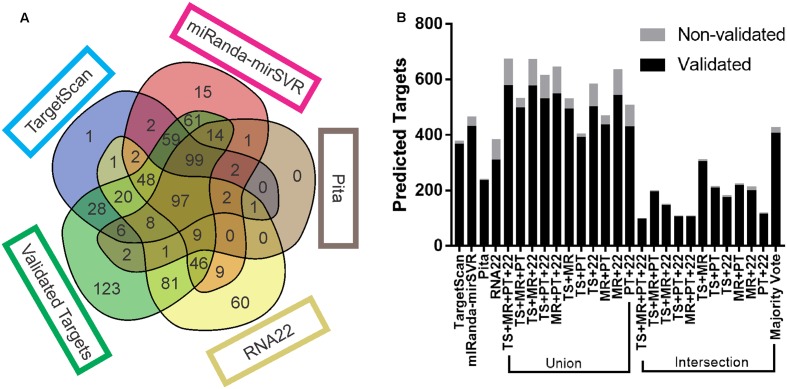
Target prediction output comparison.
(A) Venn diagram of the number of validated and non-validated targets predicted by each tool, as well as the number targets that were not predicted. (B) Total number of validated and non-validated targets predicted by each tool and combinatorial approach. Venn diagrams from all replicates are available at Supplementary Data Sheet S1.